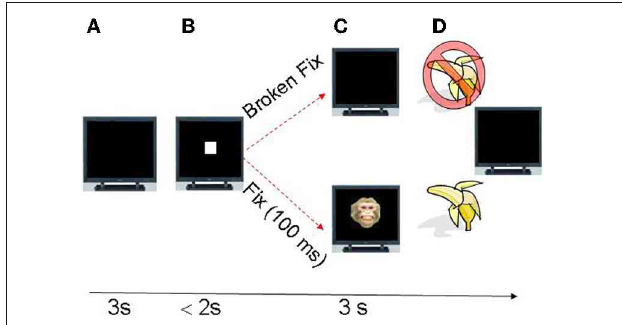
FIGURE 1 | Task progression. (A) The trial starts with an empty monitor presented during three seconds (inter-trial period). (B) At the end of the inter-trial interval a fixation icon (white square) appeared in the center of the monitor and the monkey was required to make a saccade within 2s to fixation area subtending three degrees of visual angle (dva) centered on the fixation icon (fixspot). (C) If the eyes remained fixated for 100ms, an image appeared which the monkey was allowed to freely view. The trial was aborted without reward if the monkey failed to fixate on the fixation icon for 100ms and the monitor became blank. (D) Juice reward was delivered if gaze was maintained within the boundary of the image for